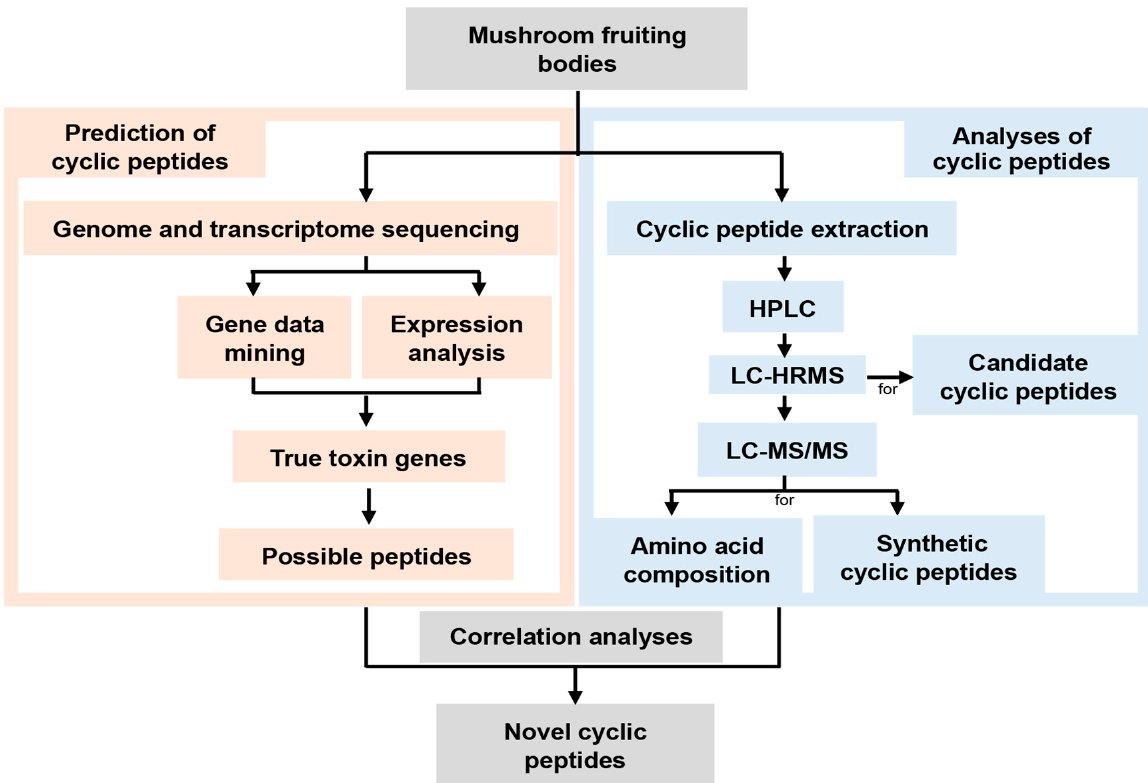
Figure 2. A flowchart for characterizing cyclic peptides in Amanita species. HRMS: high resolution MS. Table 1. The MSDIN gene family in Amanita rimosa.